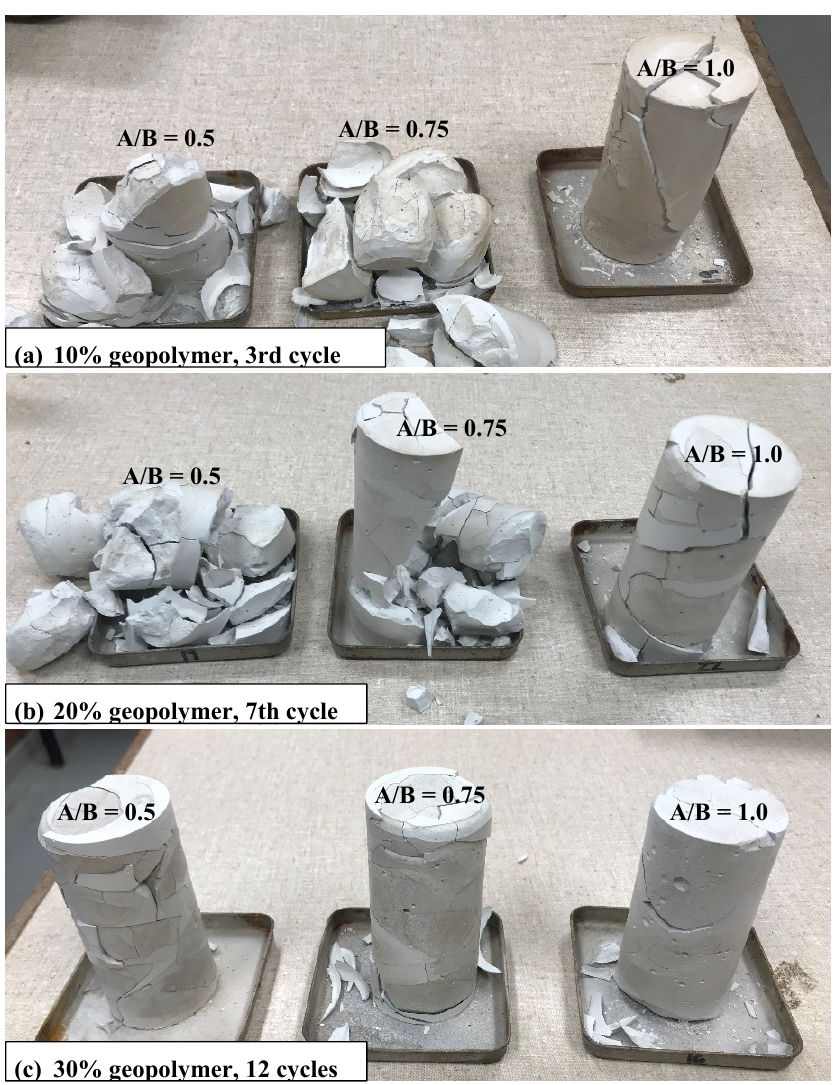
Figure 10. Wetting–drying durability performance of different geopolymer-treated clay mixtures: ( a ) 10% geopolymer; ( b ) 20% geopolymer; and ( c ) 30% geopolymer.